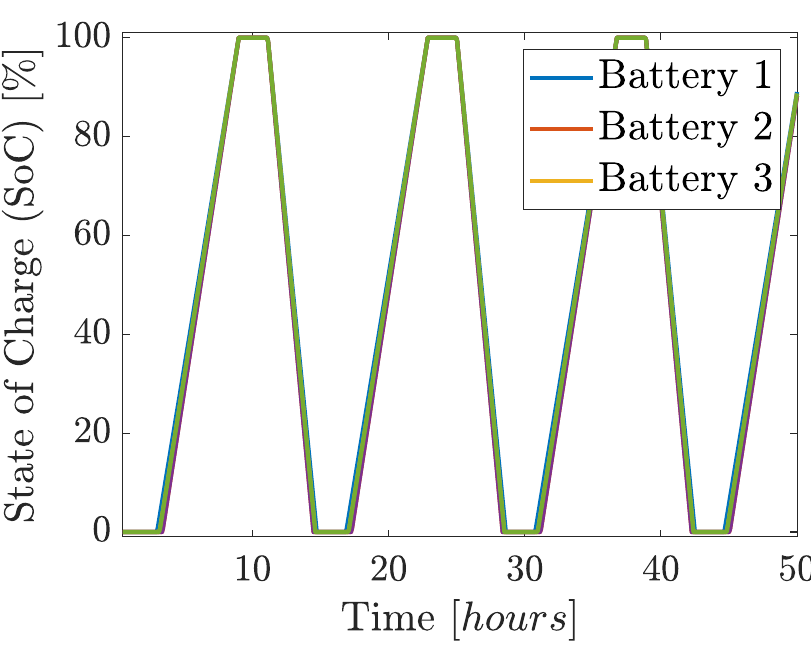
Figure 25. State of Charge values considering the SoH strategy.